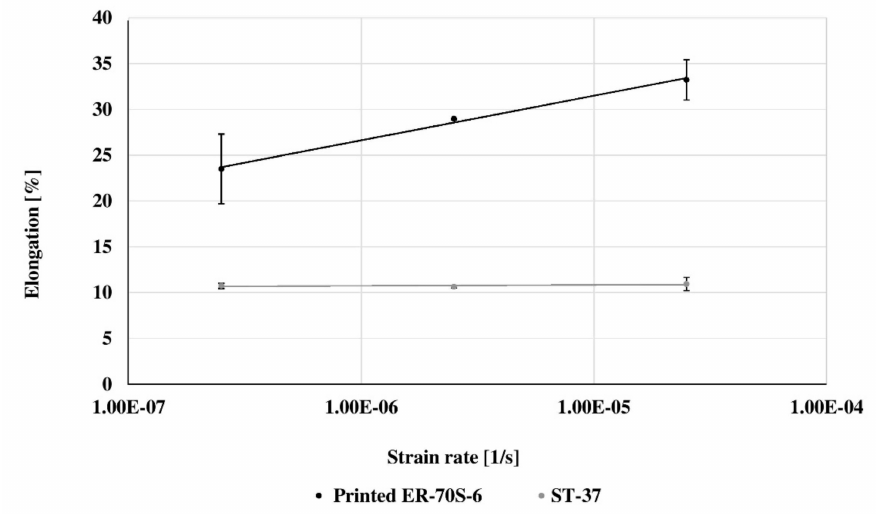
Figure 15. The e ff ect of strain rate on the elongation of printed ER70S-6 alloy and reference alloy ST-37, as obtained by